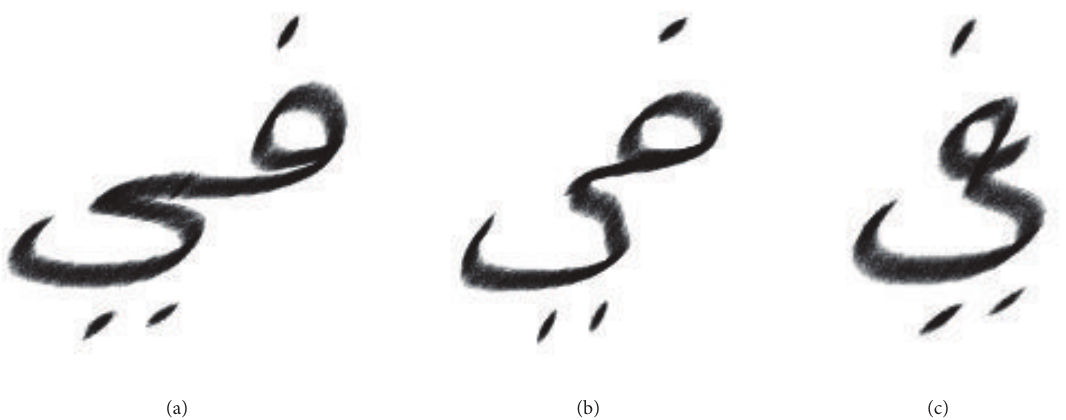
Figure 8: Example for a synthesized letter pair using (a) full (b) half and (c) negative Kashida length.